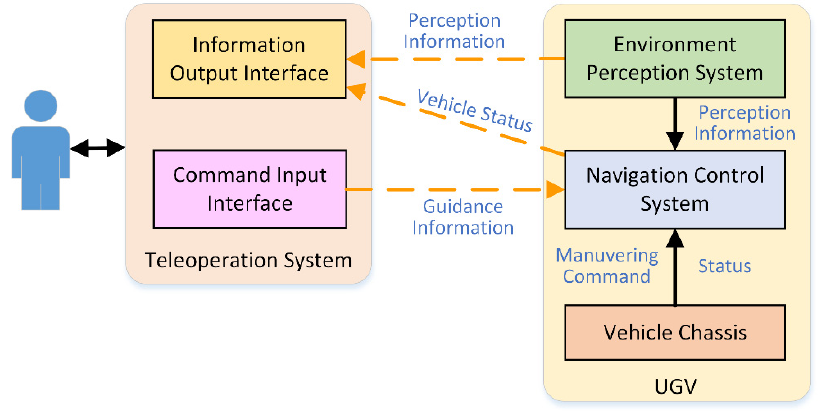
Figure 3. System overview of guidance interaction cooperative control.